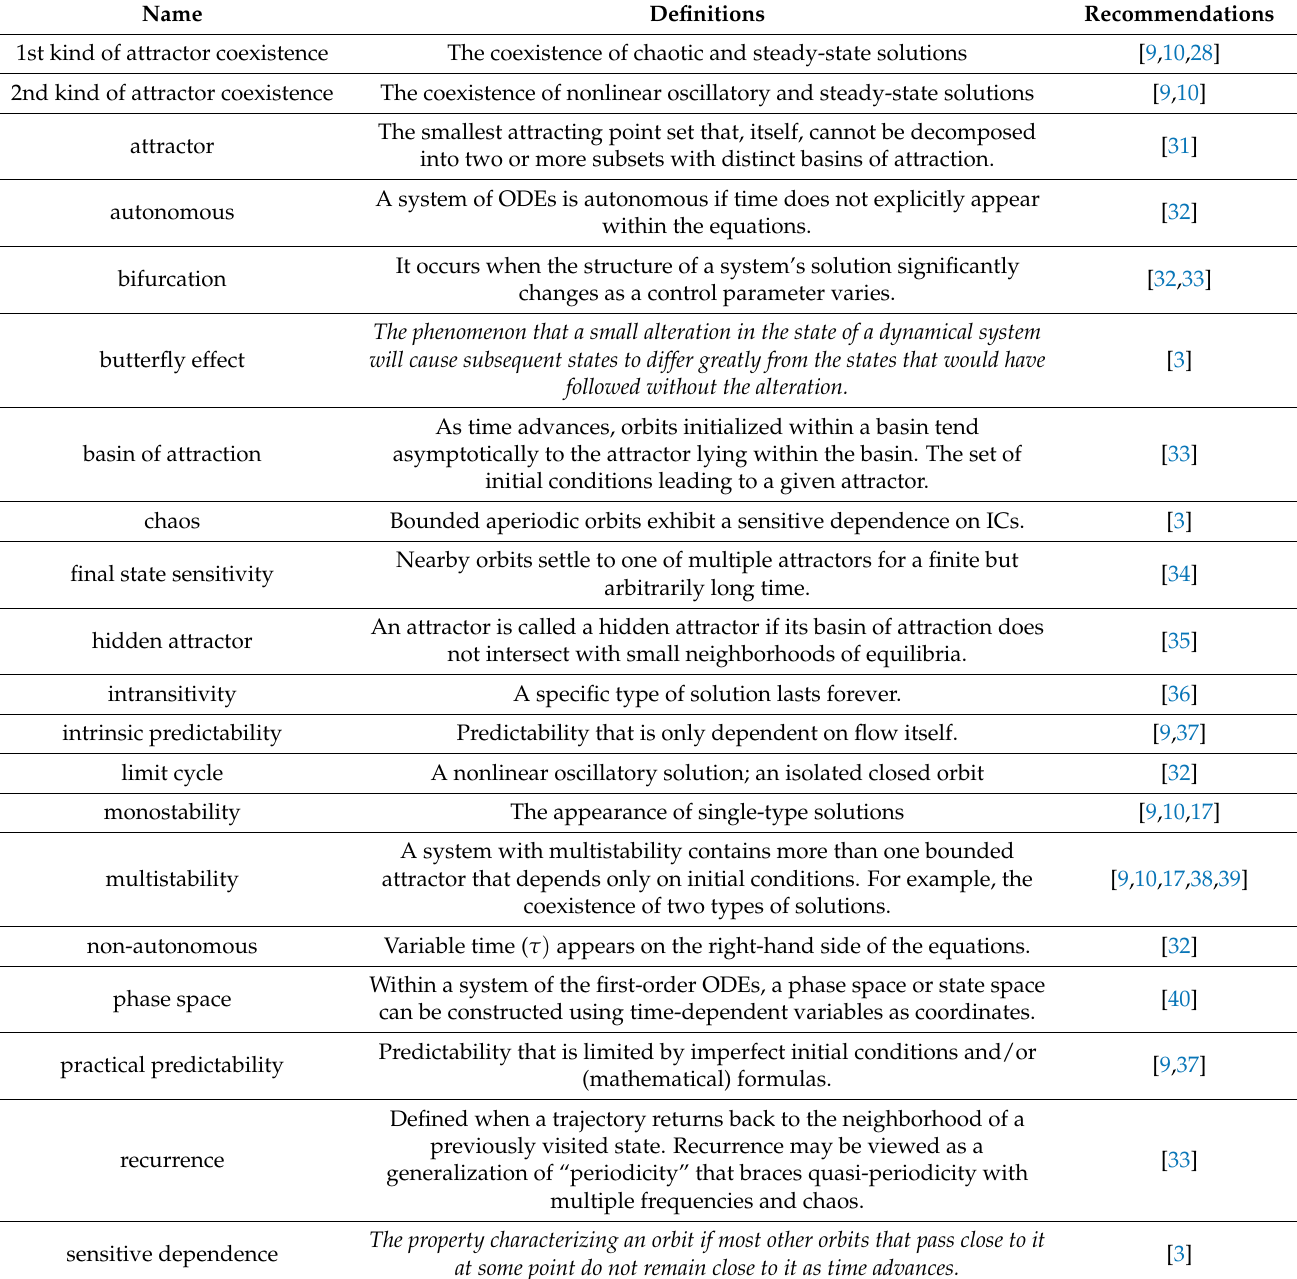
Table 1. The definitions of concepts related to predictability and